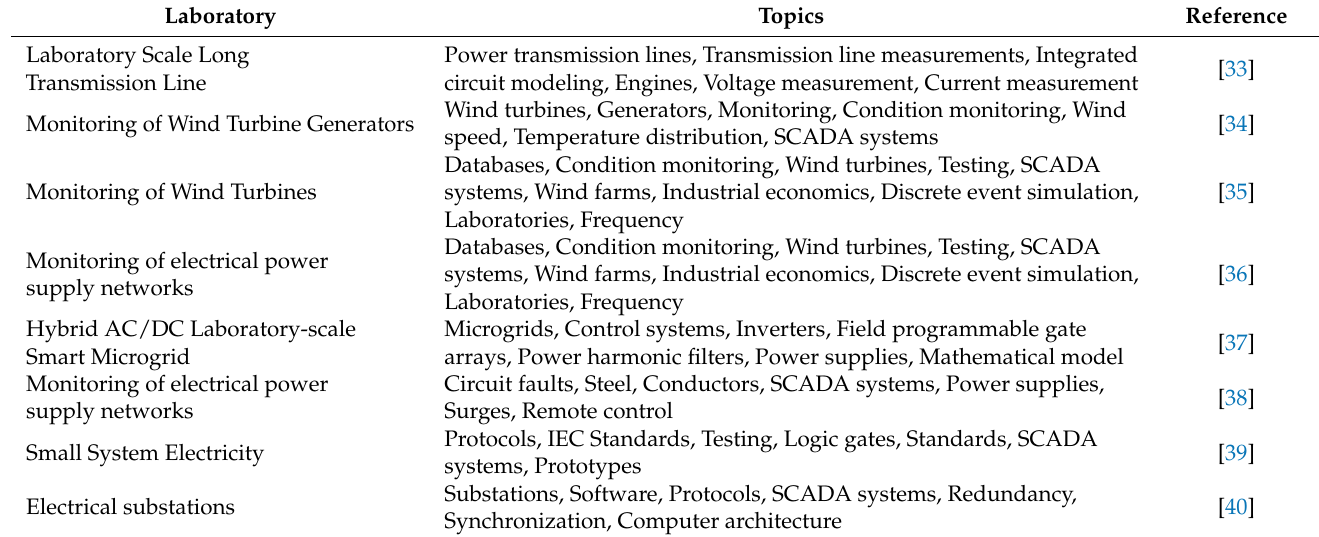
Table 2. SCADA for electrical power